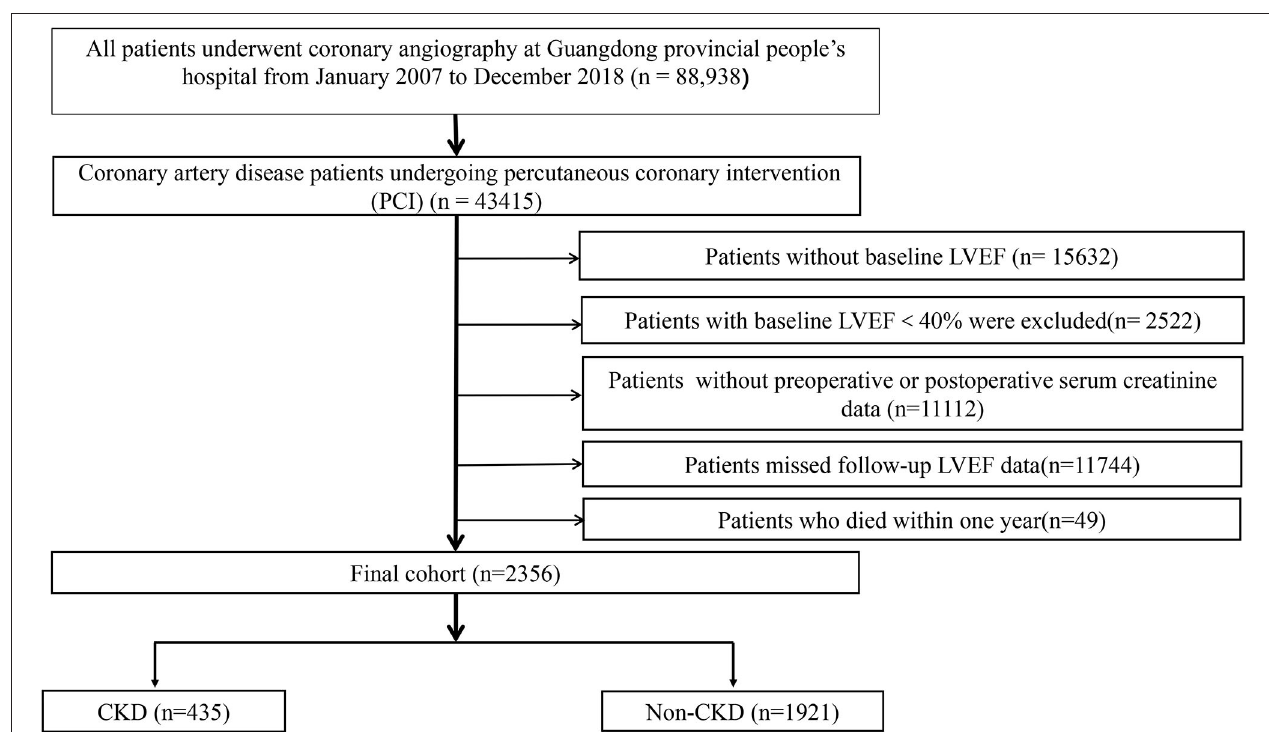
FIGURE 1 | Flow chart of the study population. LVEF, left ventricular ejection fraction; CKD, chronic kidney disease.